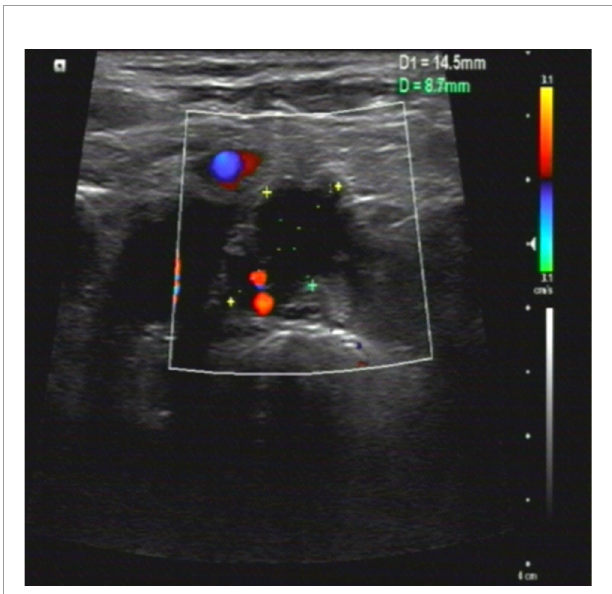
FIGURE 1 | Ultrasonography features of the case. Ultrasonic images showed a 1.5 * 0.9CM hypoechoic nodule in the left supraclavicular area, with abundant blood fl ow signals, which indicated cancer metastatic lymph